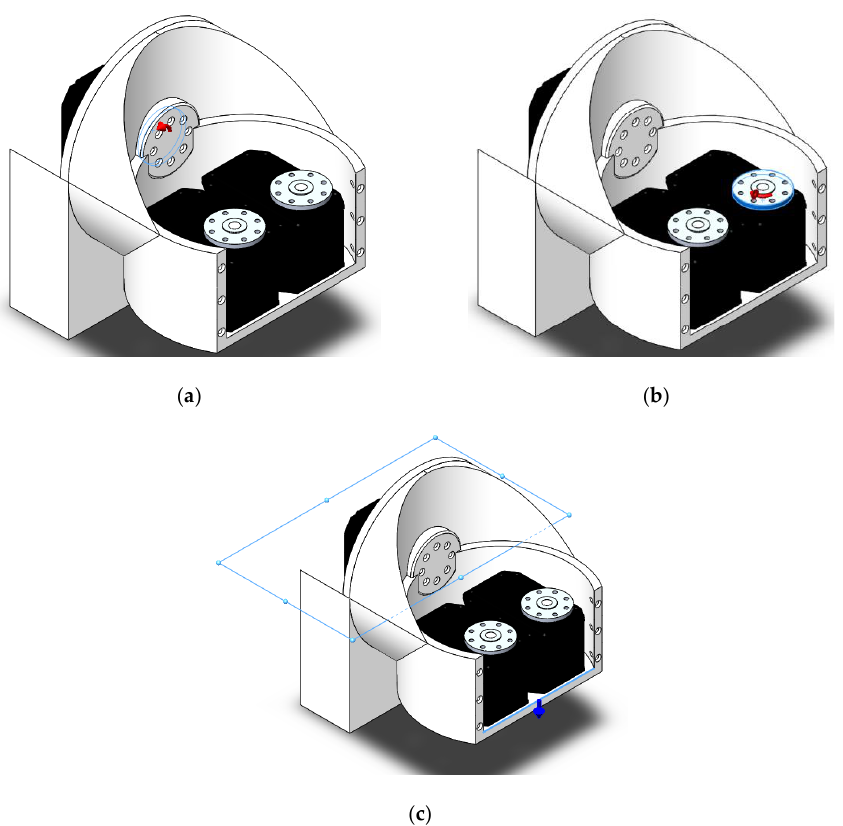
Figure 9. Simulation models for the motor unit: ( a ) Angular displacement of the shoulder application detail, ( b ) Angular displacement of the arm application detail, ( c ) Full arm payload force application detail.